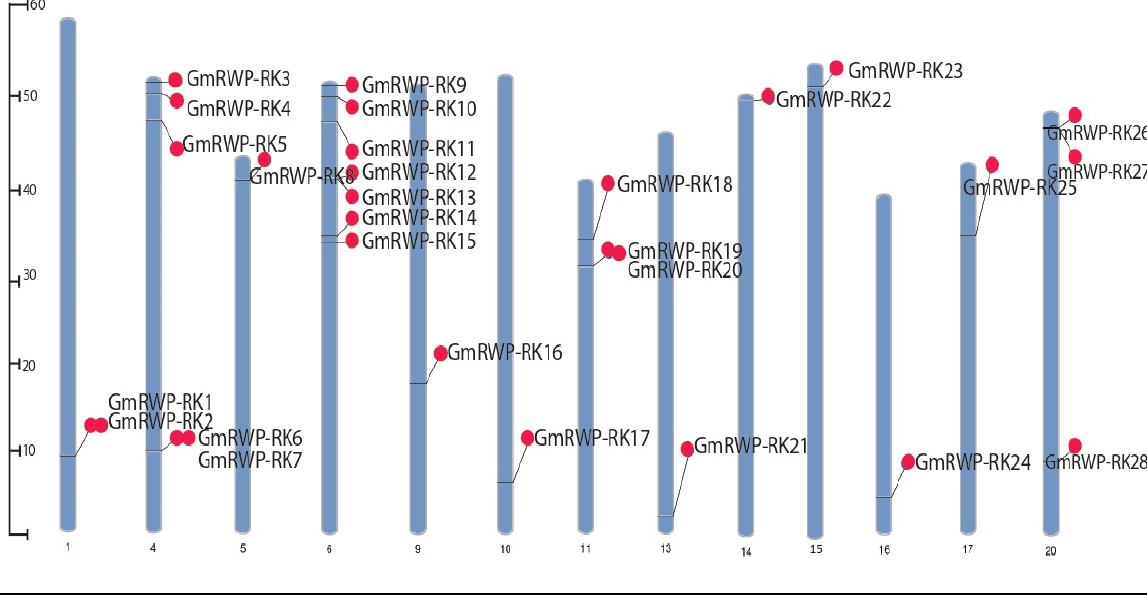
Figure 2. Chromosomal mapping of GmRWP ‐ RK genes in soybean. The distribution of GmRWP ‐ RK genes on 20 different chromosomes are shown with red circles.